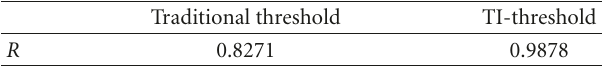
Table 2: Correlation coe ffi cients of two results with original signal.